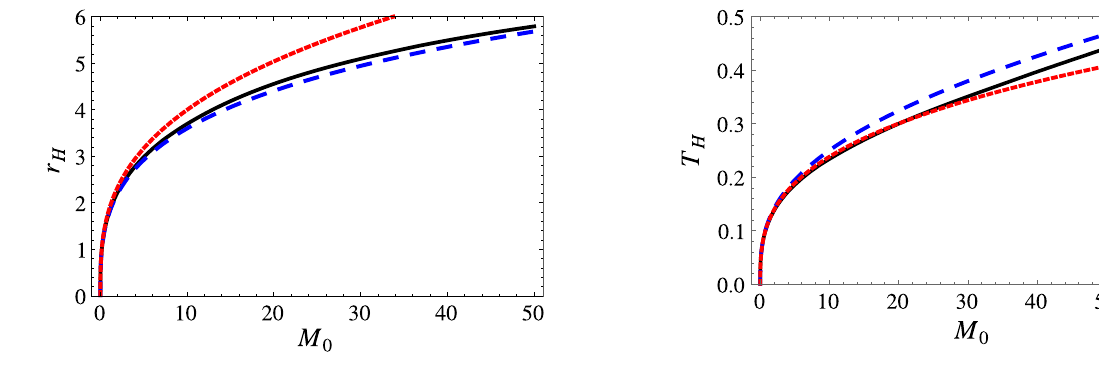
Fig. 5 Hawking temperature as a function of M 0 for (cid:13) = 0 . 05, L = 2 and G 0 = 0 . 8. The plots for the numerical solution, the expansion for (cid:13) (cid:12) 1 and the classical case correspond to the black solid line, dashed blue line and short dashed red line, respectively